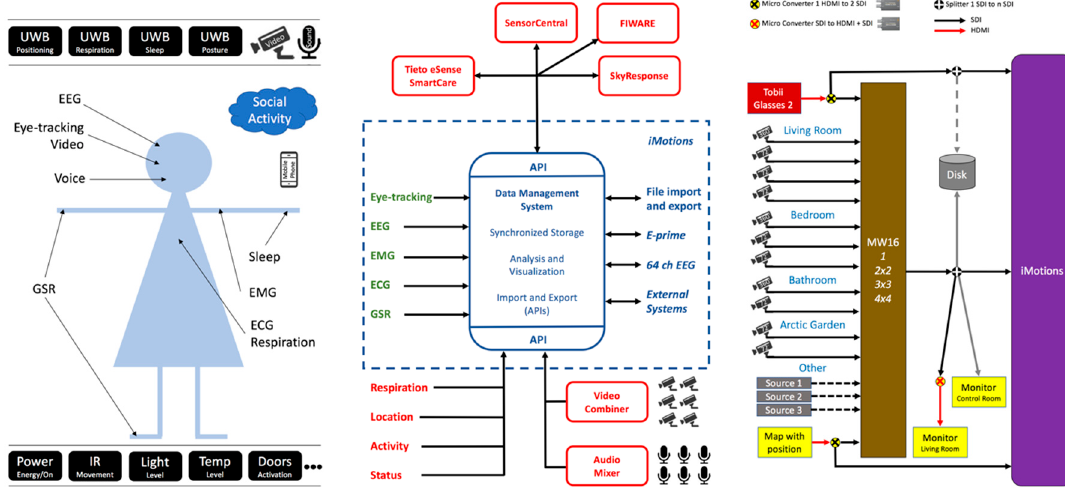
Figure 2. Systems in the H 2 Al: sensing ( Left ), data exchange ( Middle ) and AV ( Right